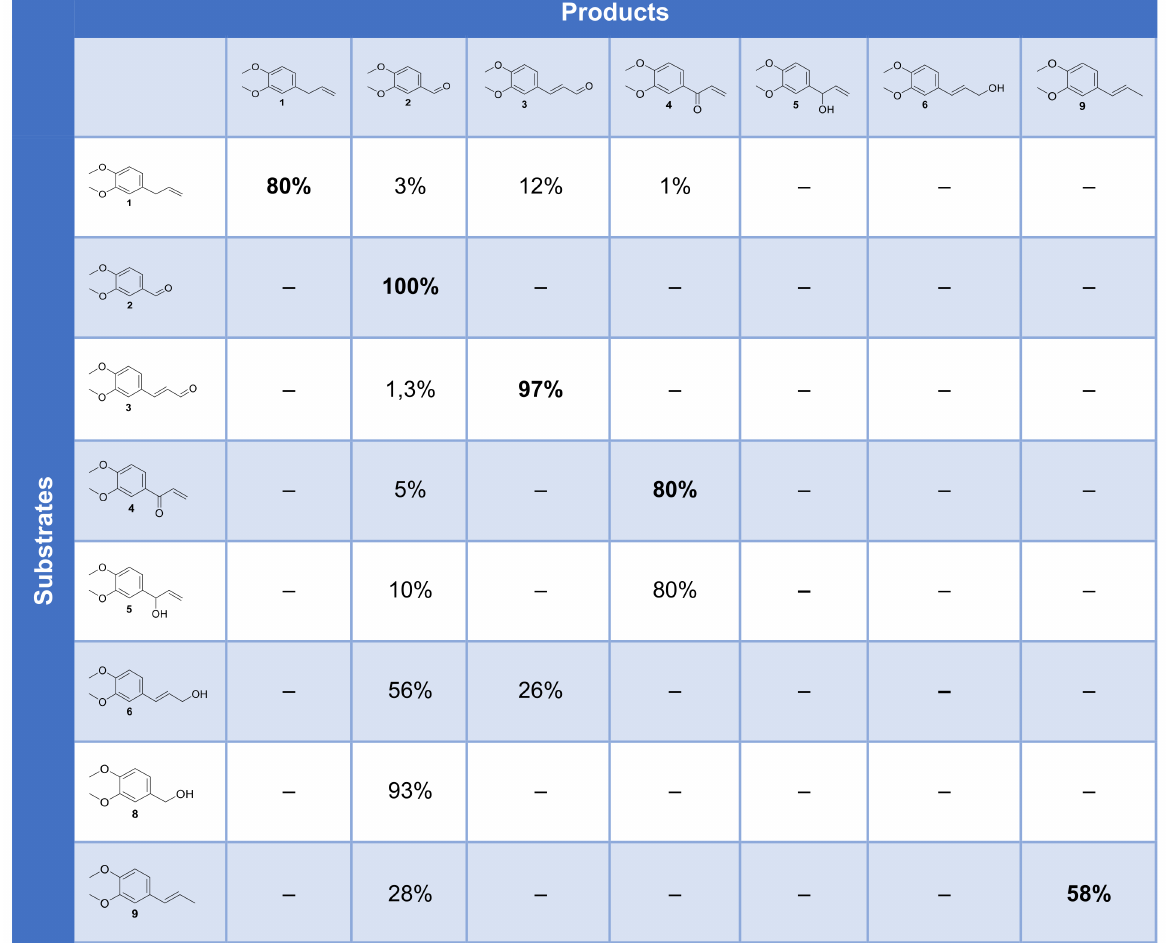
Figure 14. Cross-table of the conversion of substrates and intermediates by the laccase–mediator